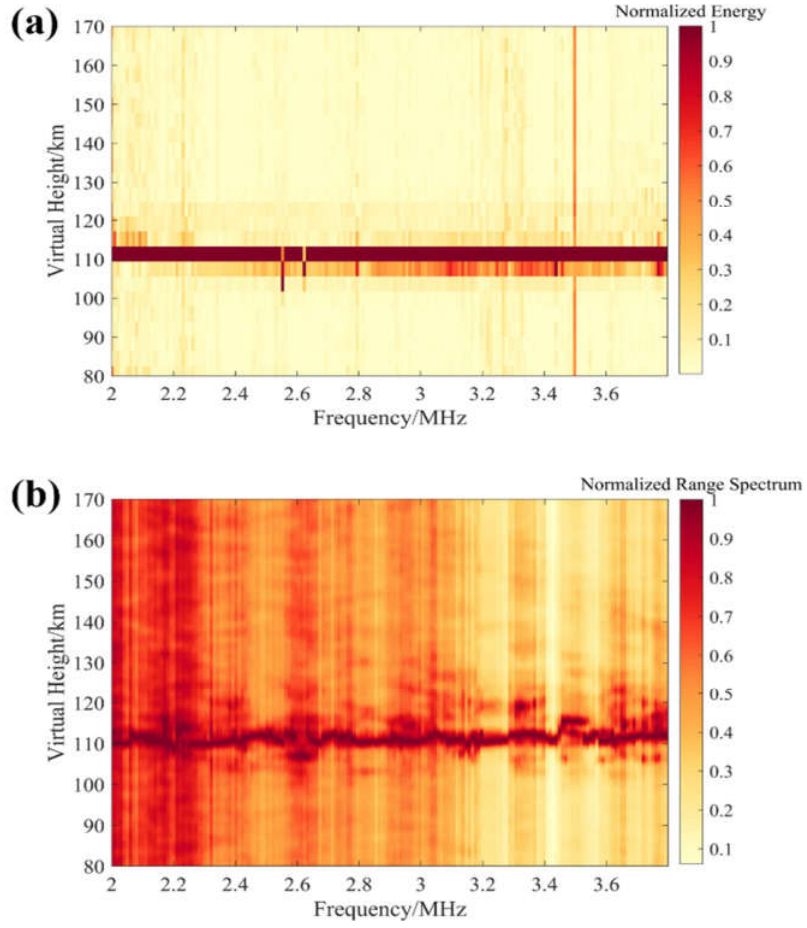
Figure 2. An example of quiet Es layer measured near Wuhan, China at 22:34 LT (UTC+8) on 8 June 2021. ( a ) Ionogram with an intrinsic range resolution of 3.84 km. ( b ) Ionogram with a range resolution of 38.4 m as obtained using the FDI technique.